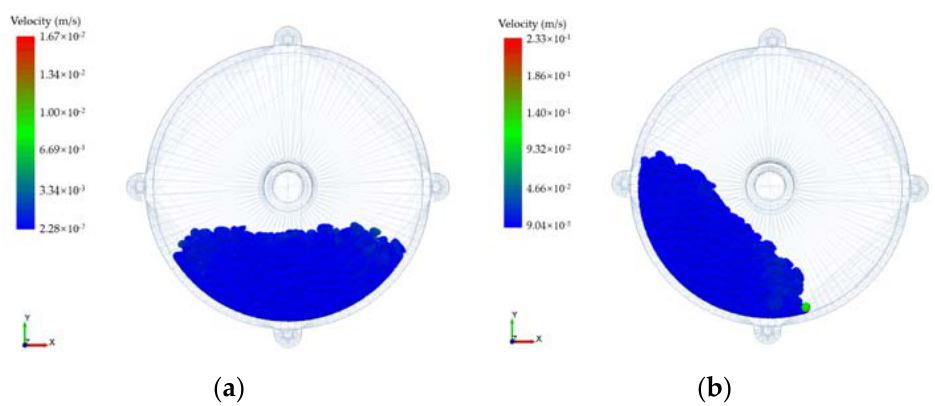
Figure 9. Simulation pretest of drum. ( a ) Before rotation; ( b ) after rotation.